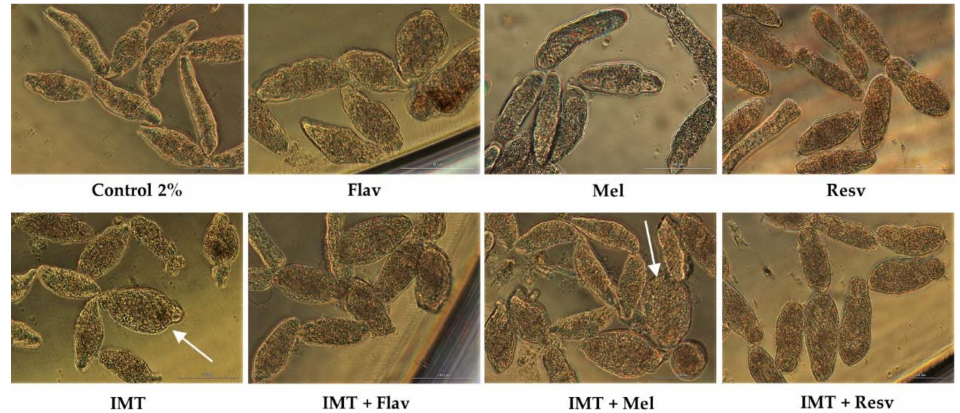
Figure 7. Micrographs of NTS at 72 h of exposure to IMT, Flav, and Resv, Mel alone or combined at a concentration of 100 µ M and 1:1 constant ratio; x20; bright field; scale bar, 100 µ m.